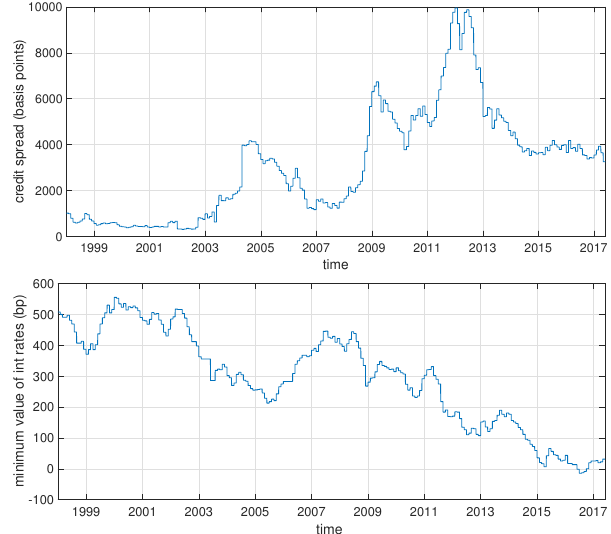
Figure 1. Total interest rate paid by all countries./Minimum value of interest